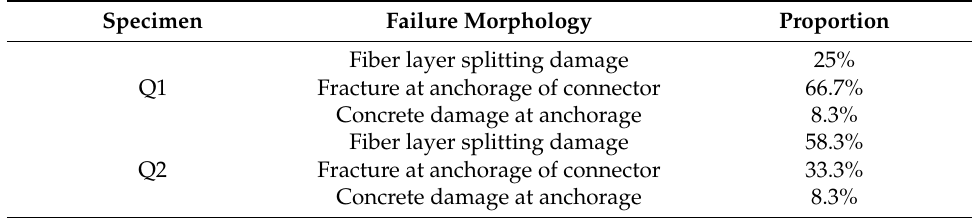
Table 5. Failure morphology of FRP connectors.